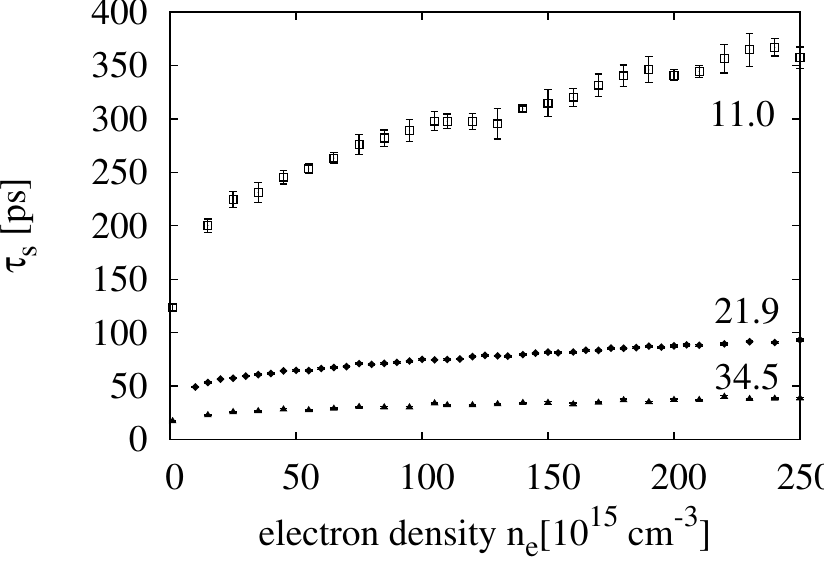
vs. density from simulations, including electron-electron Figure 8. Spin relaxation time τ s interaction, and for three different values of the spin-orbit coupling, γ 34 . 5 eV ˚A 3 . Other parameters: N = 25 × 10 3 and T = 300